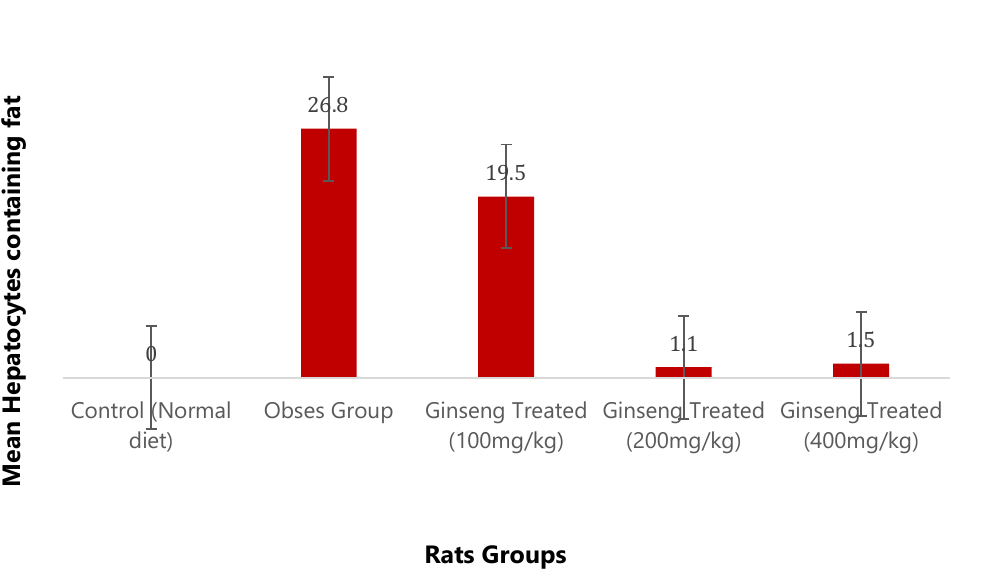
Figure 2: Comparison of mean hepatocytes containing fat droplets in different groups.